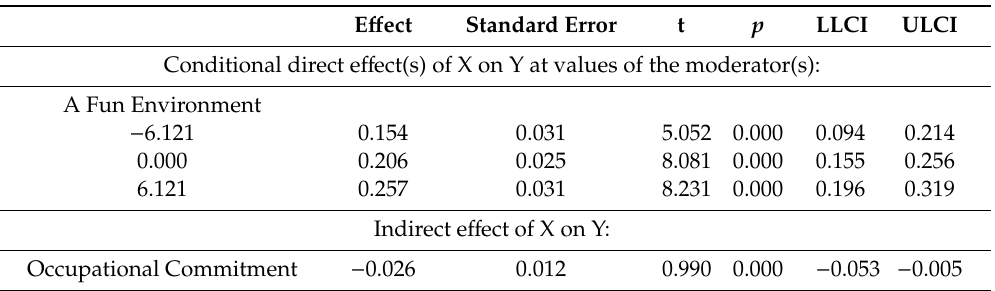
Table 5. Results of Model 8 Test.